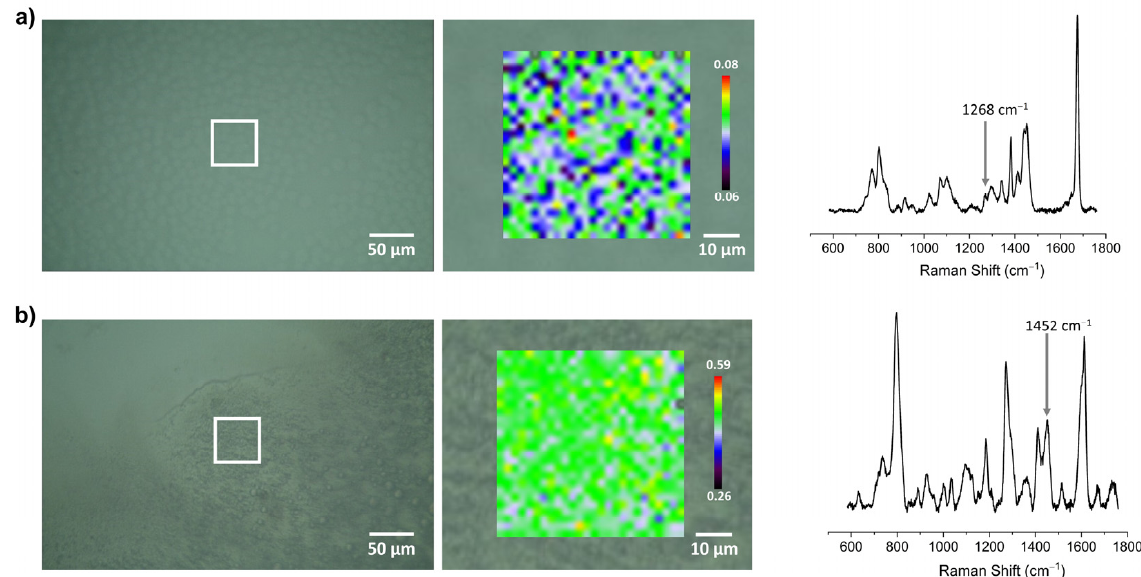
Figure 6 . Raman maps of Z-E-50 ( a ) and Z-L-50 ( b ) illustrating distribution of the characteristic functional groups (with corresponding optical micrographs in the background) and spectra of selected regions.